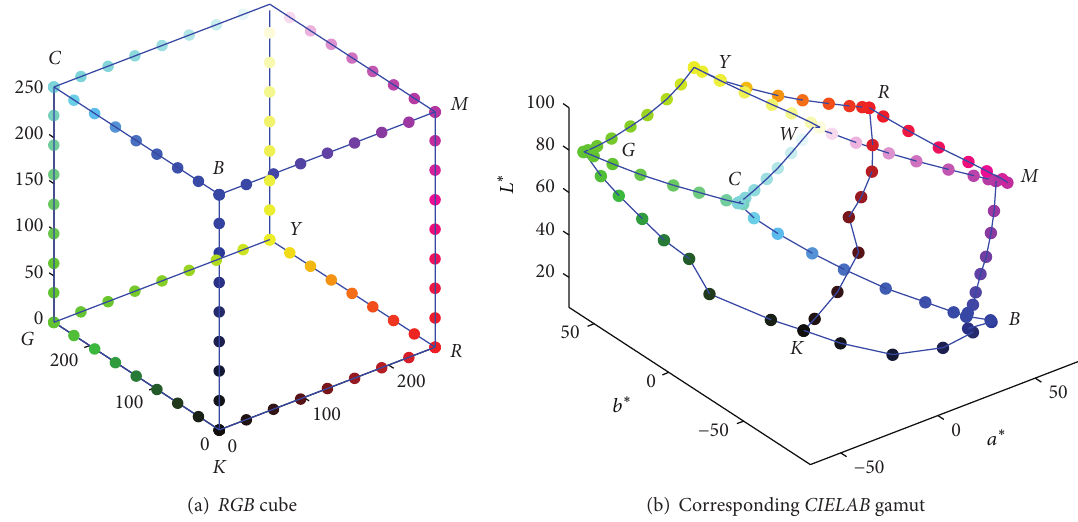
Figure 1: Gamut boundary formed by 12 edges of RGB